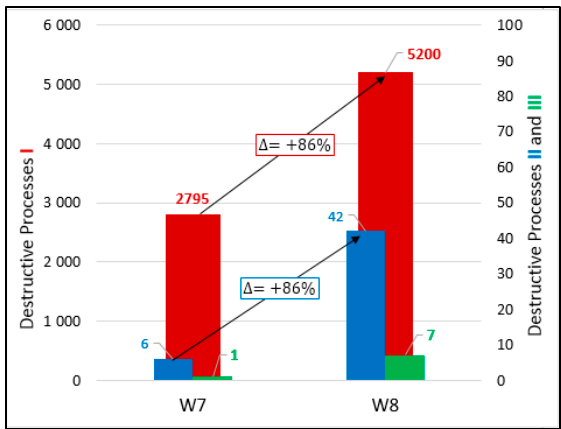
Figure 15. Number of hits accompanying processes I–III recorded in W7 and W8 samples (without curing and constant and varied temperature).